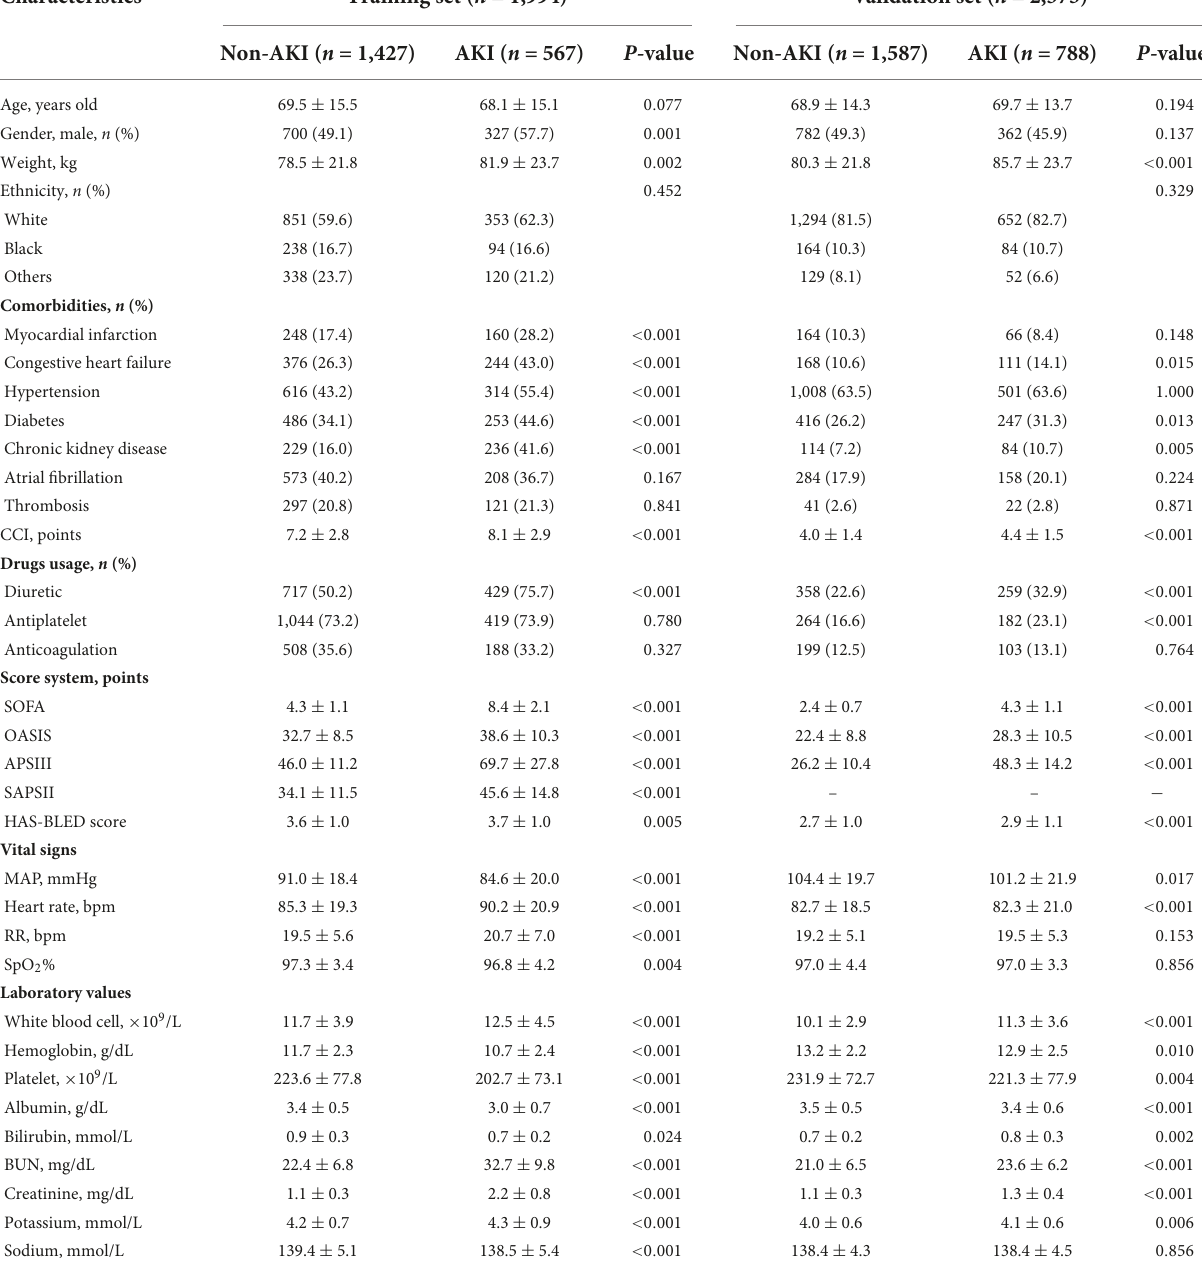
TABLE 1 Comparisons of characteristics between the non-AKI group and AKI group.